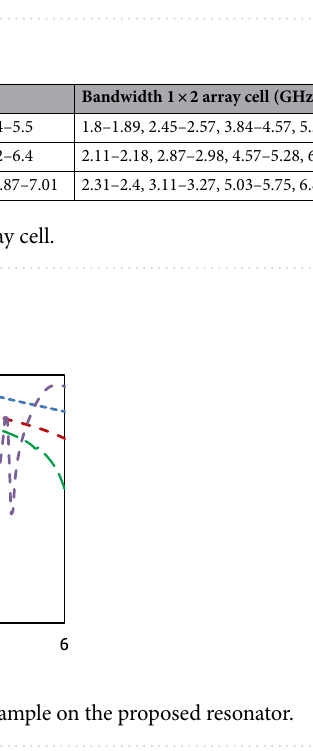
Figure 16. Transmission coefficient results of the different dielectric substrates for the unit cell ( a ) and 1 × 2 array cells ( b ).